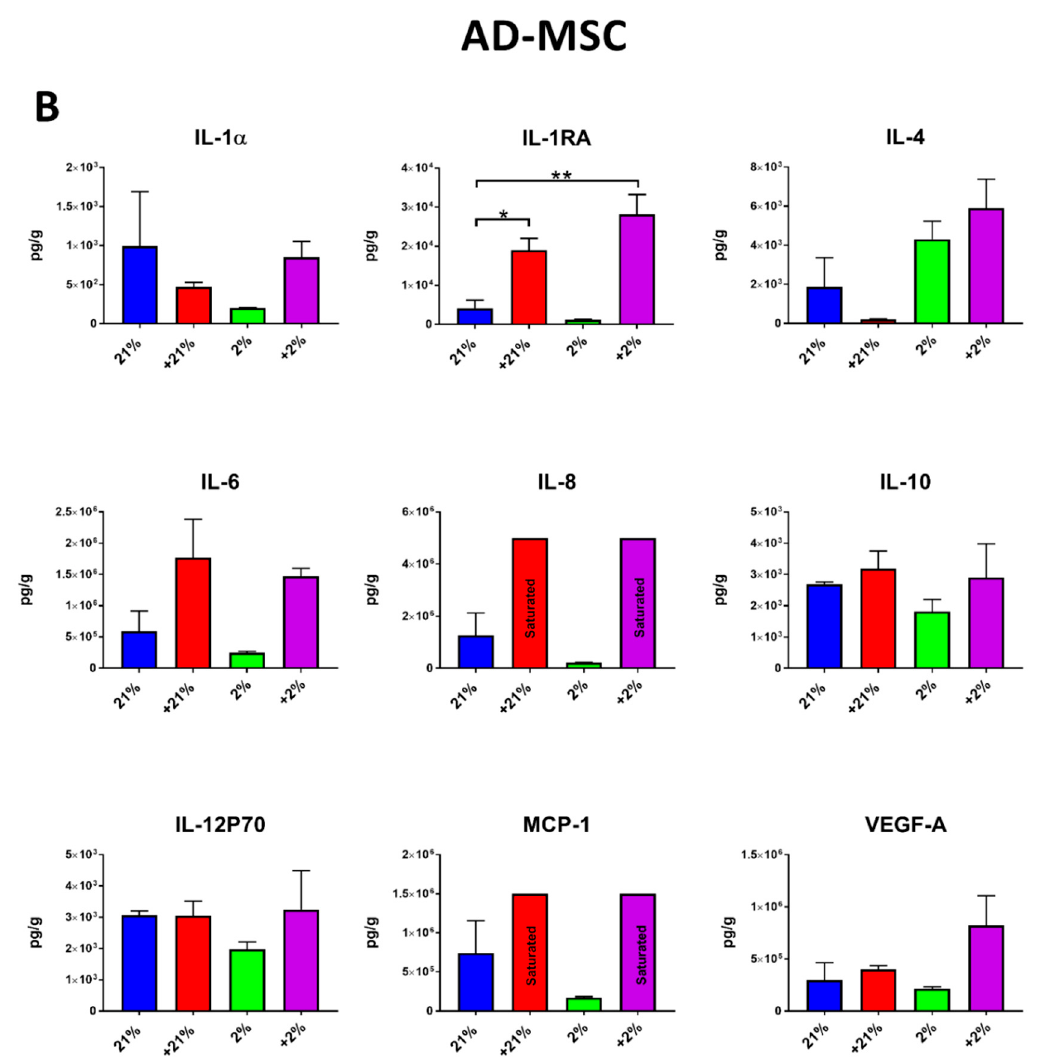
Figure 4. Secretion profile of preconditioned MSCs. ( A ) In BM-MSCs, IL-1RA and IL-8 were increased in Cytomix-treated cells. ( B ) In AD-MSCs, similar to in BM-MSCs, increases were seen in levels of IL-1RA and IL-8 following Cytomix treatment, as well as an increase in MCP-1 secretion. In addition, Cytomix-hypoxia preconditioning yielded further increases in levels of IL-1 α , IL-4, IL-10, and IL-12. * p < 0.05, ** p < 0.01, *** p < 0.001.